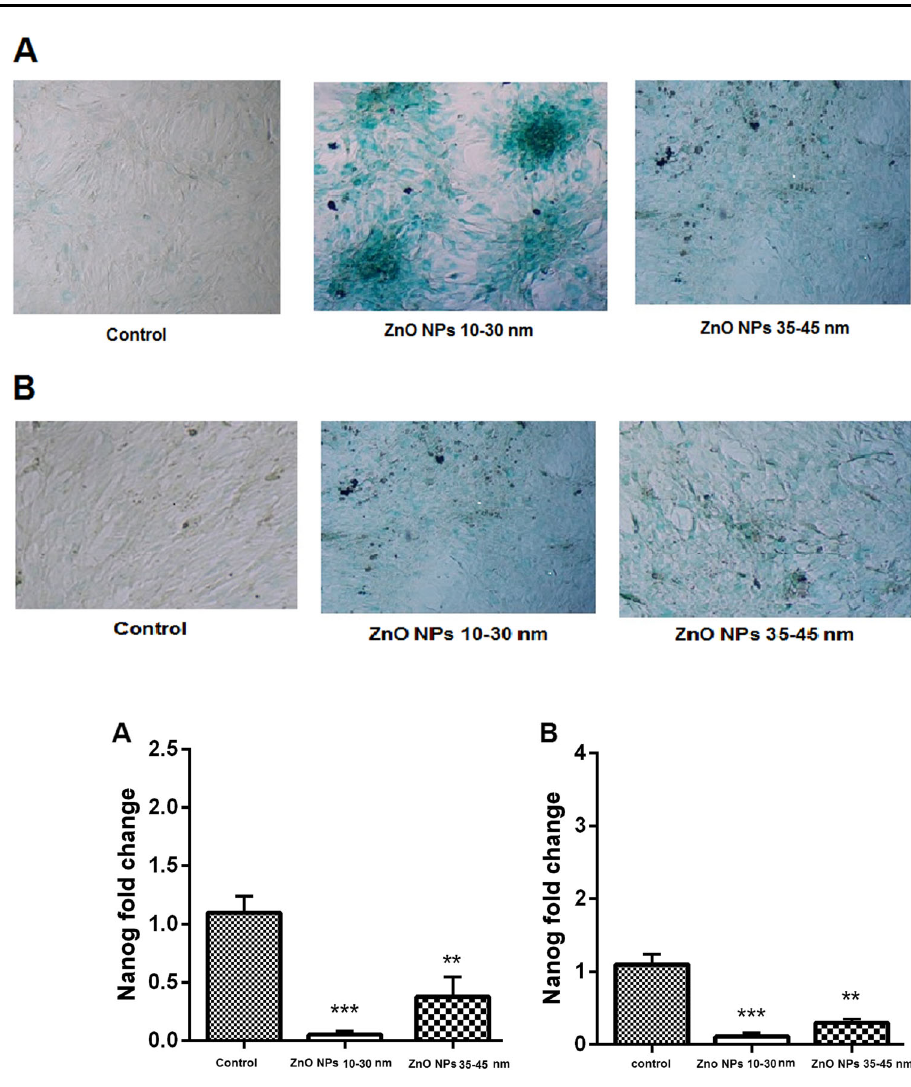
Fig. 5 Senescence-associated- β -galactosidase (SA- β -gal) staining in the AMSCs and BMSCs. SA- β -gal-positive cells could be observed more frequently in the treated AMSCs ( A ) and BMSCs ( B ) by ~10 – 30 and 35 – 45 ZnO NPs containing 6 and 12 µg/ml concentrations, respectively, in comparison to the control